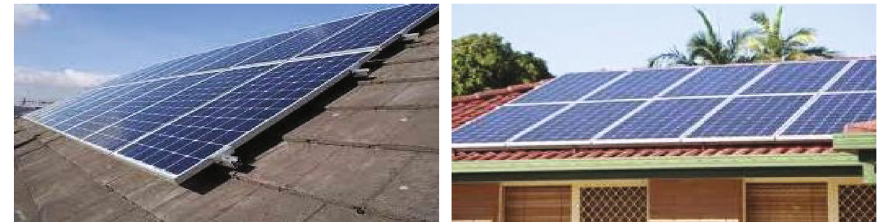
Figure 2: BAPV installation: the modules are installed on the top of the existing roof.